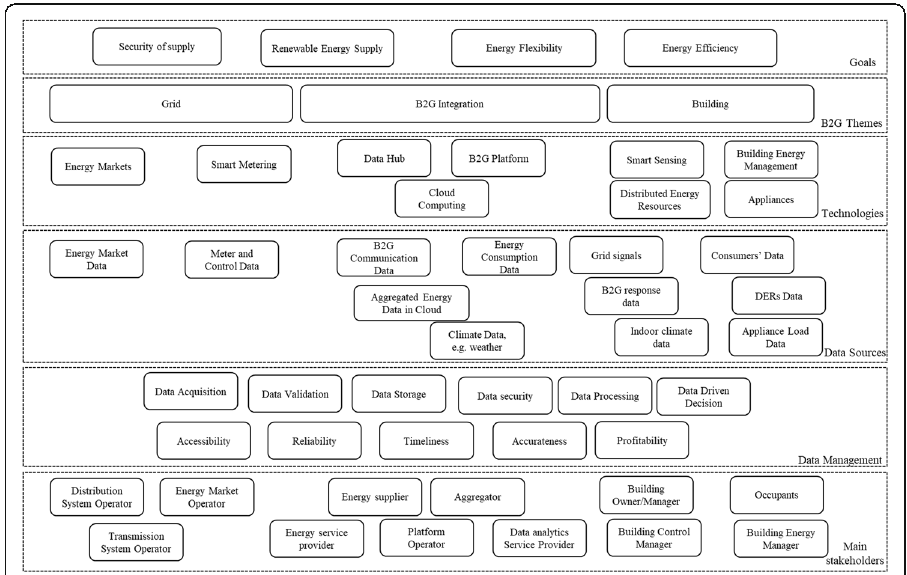
Fig. 1 The overview of the Building-to-Grid ecosystem